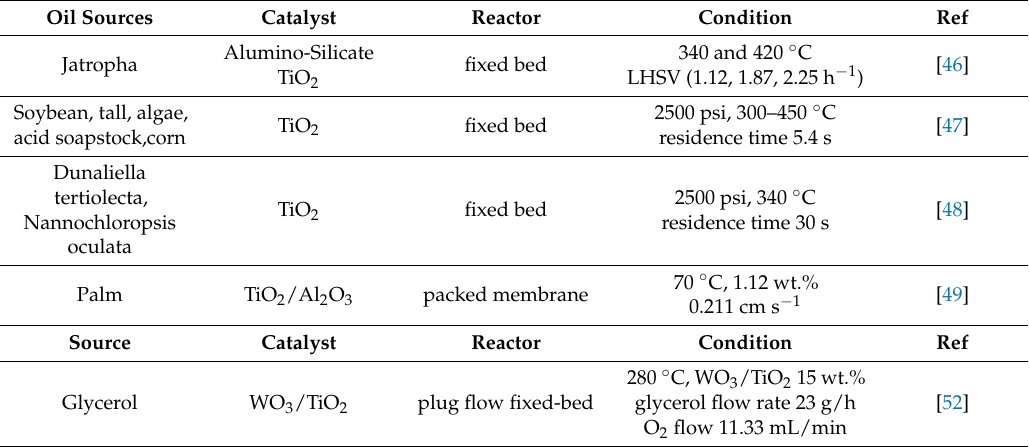
Table 19. Use of TiO 2 as catalyst in continuous flow production of biodiesel and glycerol recovery. Oil